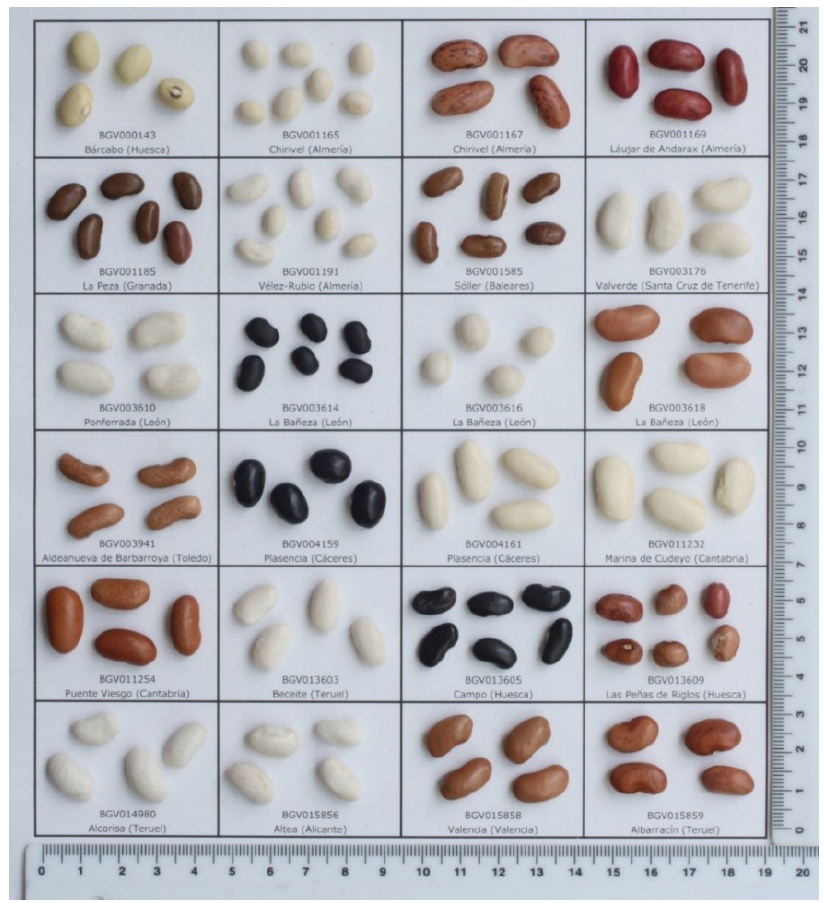
Figure 3. Seed morphology of the 24 P. vulgaris accessions.